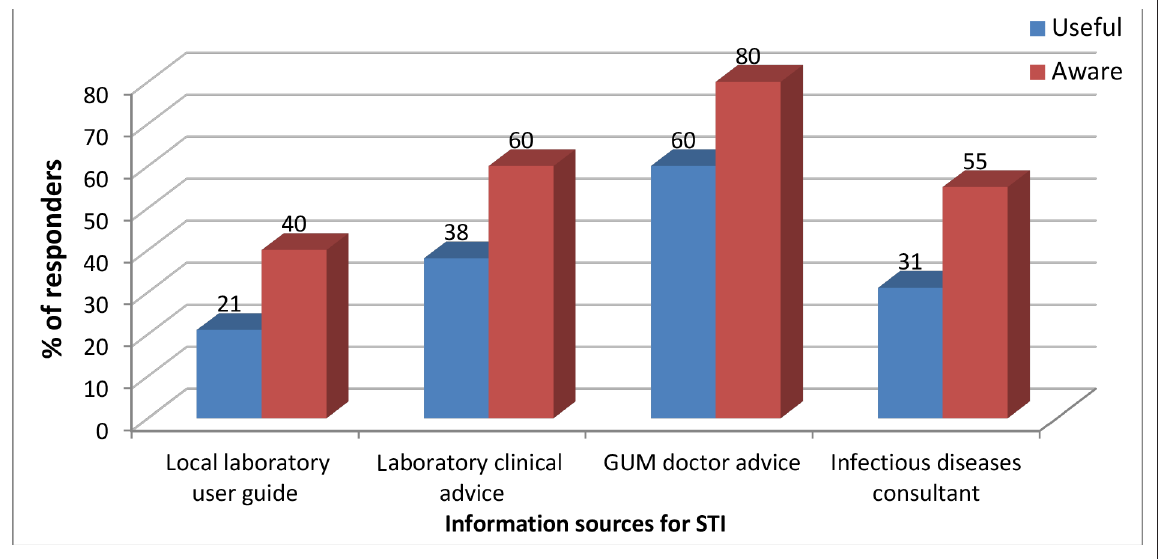
Figure 1 Responses to the question ‘Are you aware of any of the following sources of information on sexually transmitted infections and do you find them useful?’ GUM = genito-urinary medicine. STI = sexually transmitted